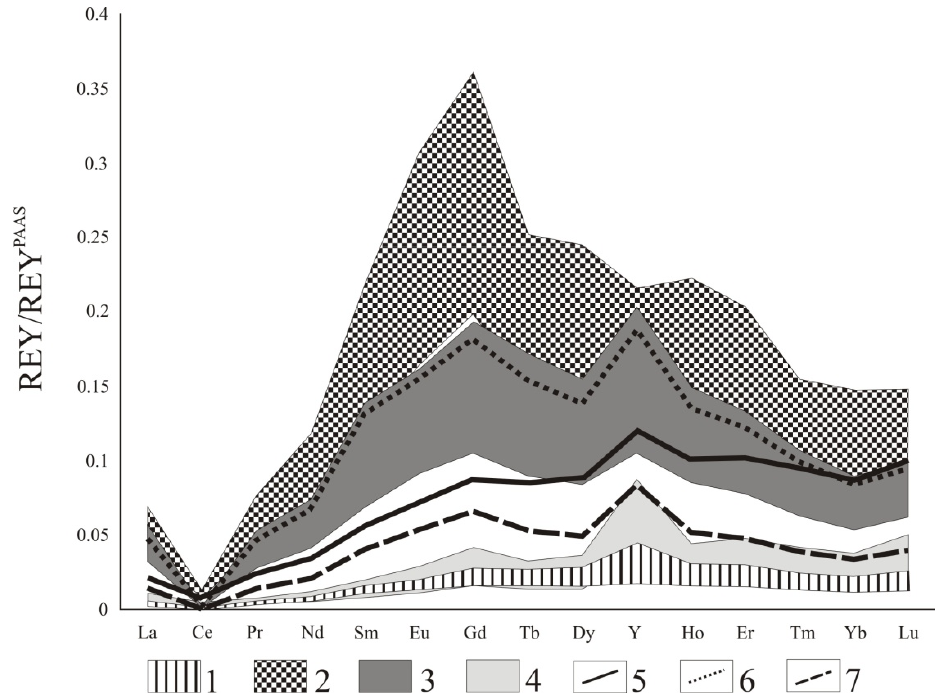
Figure 8. Shale-normalized (PAAS after [47]) REY patterns of Fe-Mn deposits of differing genesis in fraction I: 1—hydrothermal Fe-Mn deposits from the Sea of Japan, [7]; 2—hydrogenetic Fe-Mn crusts from the North Pacific, [48]; 3—Fe-Mn crusts from the Central Pacific (our unpublished data); 4—phosphatized Fe-Mn crusts from the Central Pacific (our unpublished data); 5—diagenetic ring-like Fe-Mn nodule from the Sea of Okhotsk, [52]; 6—sample 431-5; 7—sample 431A-12.